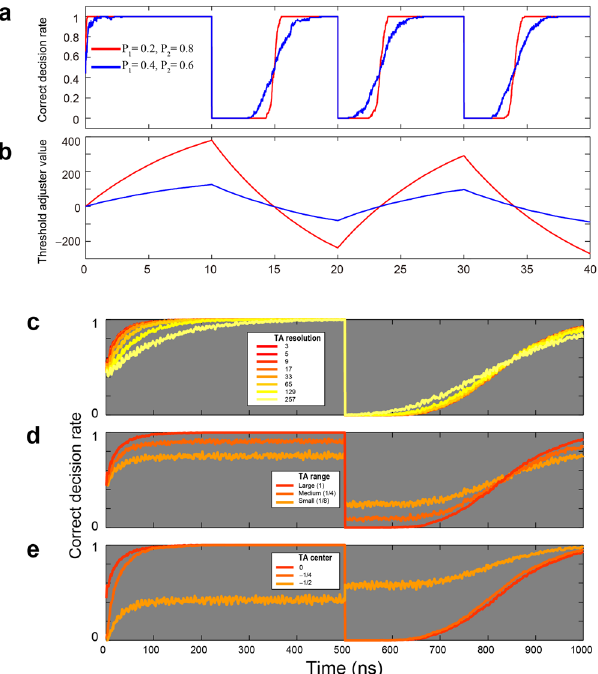
Figure 2. Reinforcement learning in dynamically changing environments. ( a ) Evolution of the correct decision rate (CDR) when the reward probabilities of the two slot machines are {0.8, 0.2} and {0.6, 0.4}. The knowledge regarding the sum of the reward probability, which is unity in these cases, is supposed to be given. The reward probability is intentionally swapped every 10 ns to represent sudden environmental changes or uncertainty. Rapid and adequate adaptation is observed in both cases. ( b ) Evolution of the threshold adjuster (TA) value underlying correct decision making. ( c–e ) CDR performance dependency on the setting of TA. ( c ) TA resolution dependency. ( d ) TA range dependency. ( e ) TA centre value